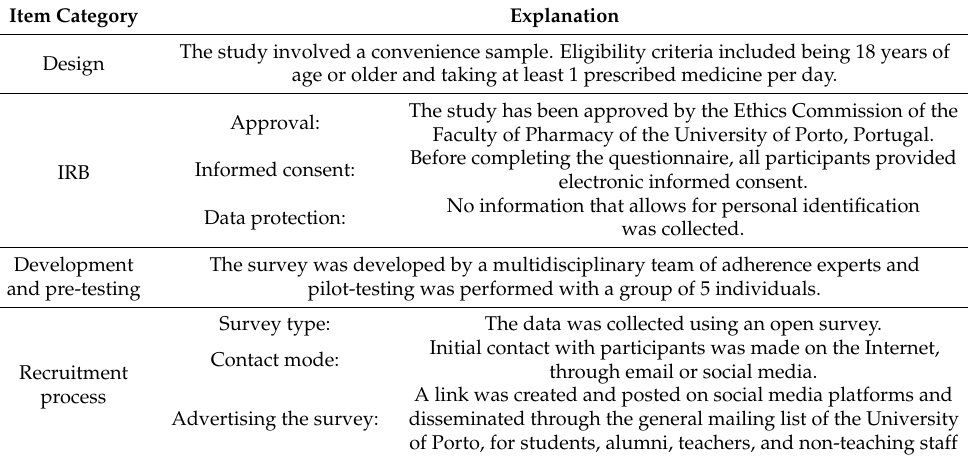
Table A1. Checklist for Reporting Results of Internet E-Surveys